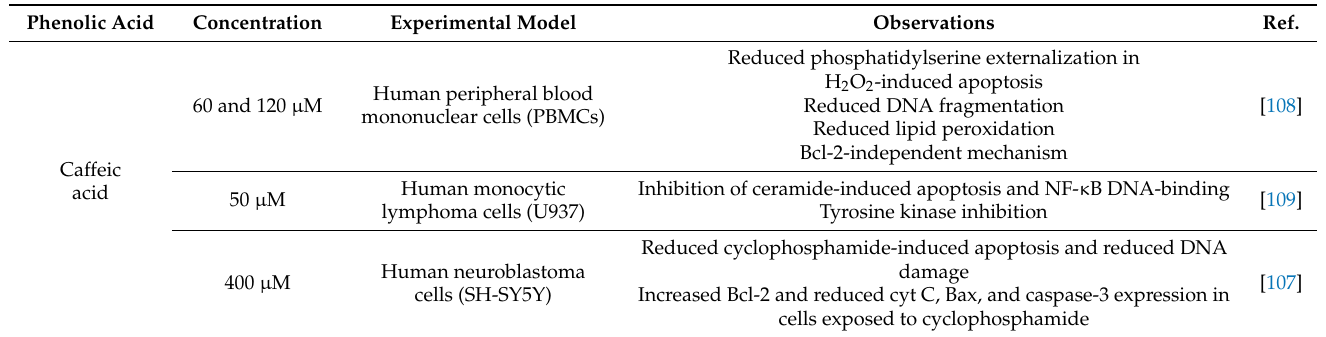
Table 2. Cell survival modulation by common phytochemicals from Thymus spp. extracts in in vitro and in vivo animal experimental